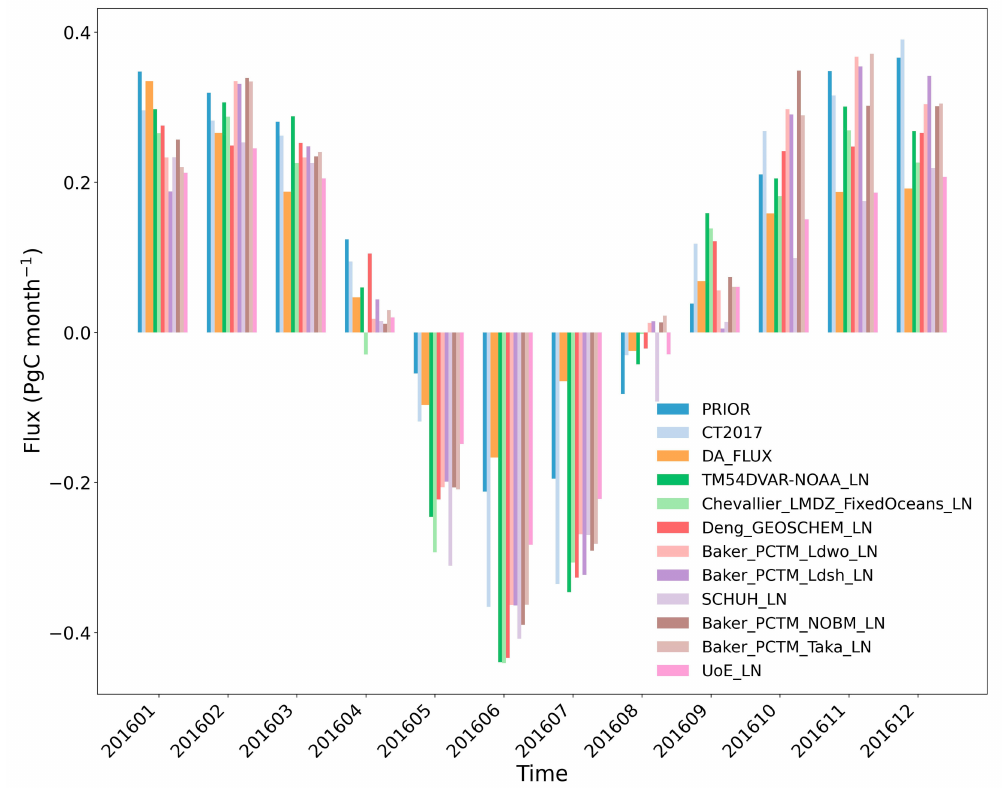
Figure 5. Comparison of the monthly posterior CO 2 flux over the contiguous United States in 2016 estimated by the DA_FLUX experiment with those estimated by CT2017 and the models from OCO-2 MIP, and with the prior CO 2 flux used in the DA_FLUX